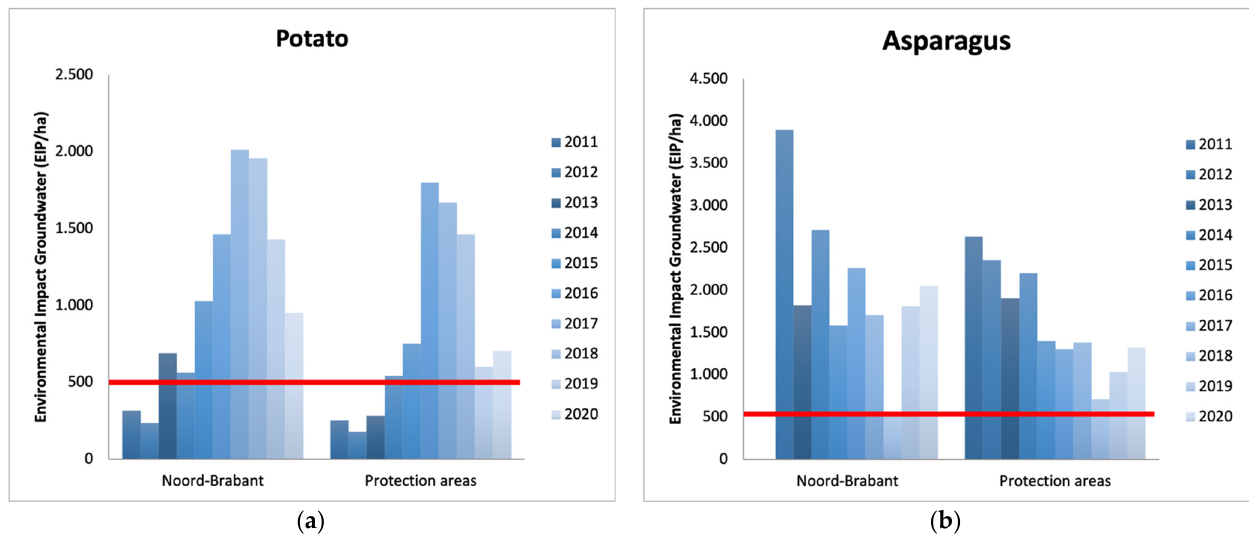
Figure 3. Environmental impact points (EIP/ha) within GWPAs and in the rest of Brabant between 2011 and 2020 for ( a ) potato and ( b ) asparagus. The red line indicates the target value of 500 EIP/ha.